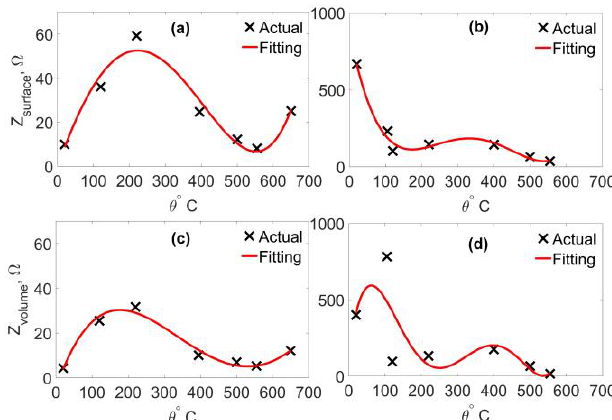
Figure 11. Trend of the temperature dependency of the surface and volume parametric impedance of the char material measured at a higher temperature over a wide frequency. ( a ) Surface impedance at low frequencies (1 Hz to 10 3 Hz); ( b ) trend of the temperature dependency of the surface impedance at high frequencies (10 4 Hz to 10 6 Hz); ( c ) volumetric impedance at low frequencies (1 Hz to 10 3 Hz); ( d ) trend of the temperature dependency of the volumetric impedance at low frequencies (10 4 Hz to 10 6 Hz).